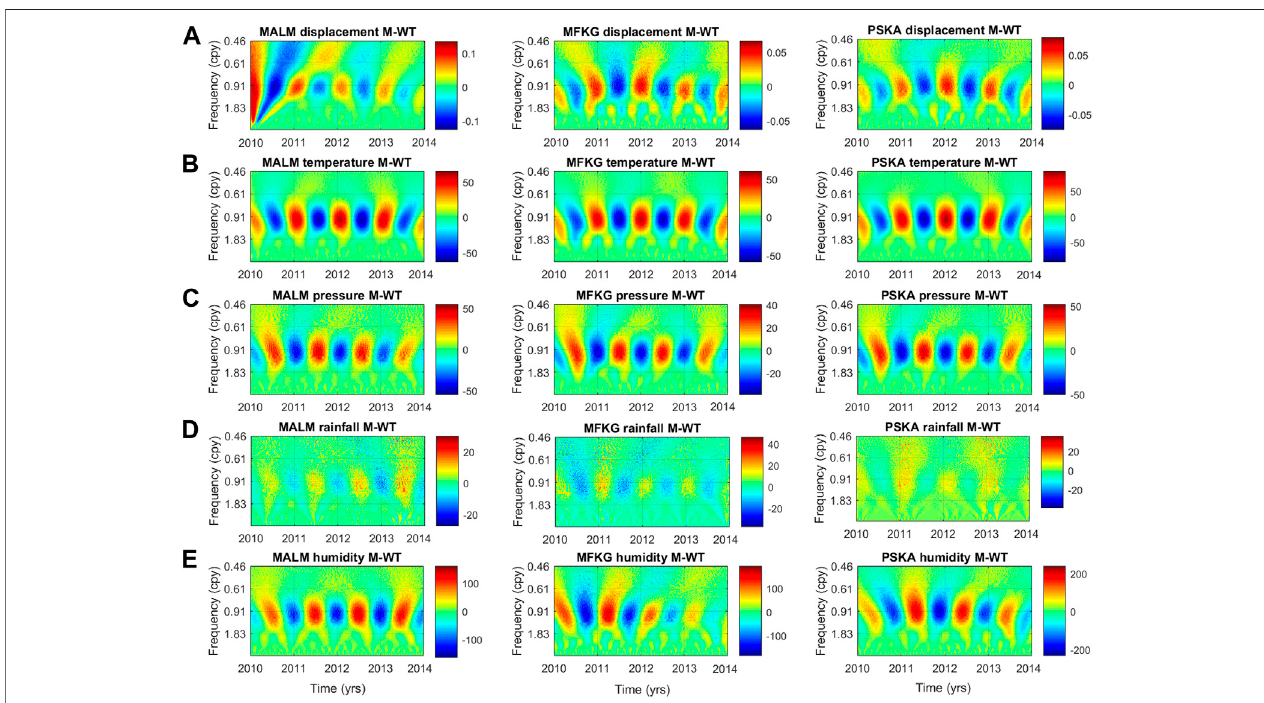
FIGURE7| WaveletTransform (WT)decompositionspectra. (A) cGPS surfacedisplacement, (B) atmospherictemperature, (C) atmosphericpressure, (D) rainfall, and (E) humidity decomposition spectra. Some of the characteristic CWT features observed in the plots are the exaggeration of low frequencies, suppression of high frequencies, and component frequency overlap. The spectra are also characterised by good time localisation. 31.